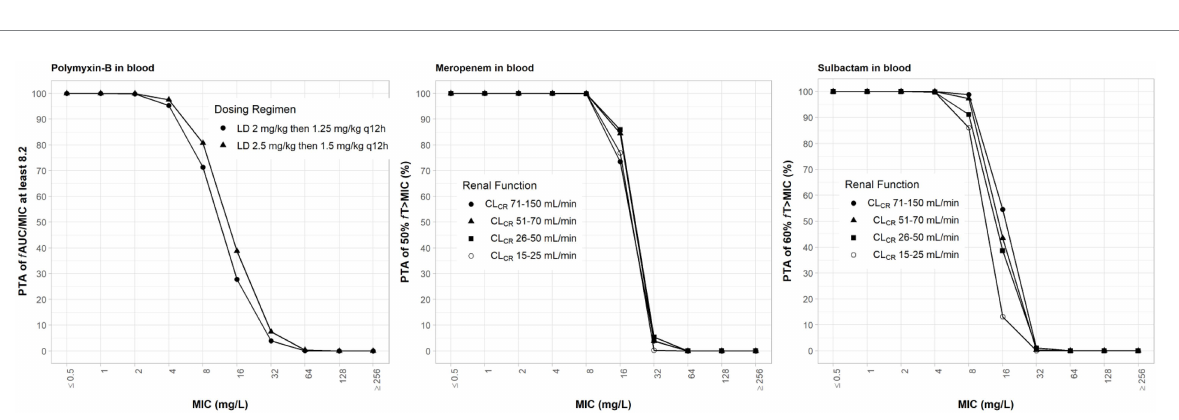
FIGURE 2 Probability of target attainment of 50% f T >MIC and 60% f T >MIC for meropenem and sulbactam dosing regimens, respectively, by renal function category and PTA of f AUC/MIC of at least 8.2 for polymyxin-B dosing regimens. Probability of target attainment values were computed based on steady-state drug concentrations in the blood. LD, loading dose; CL CR , creatinine